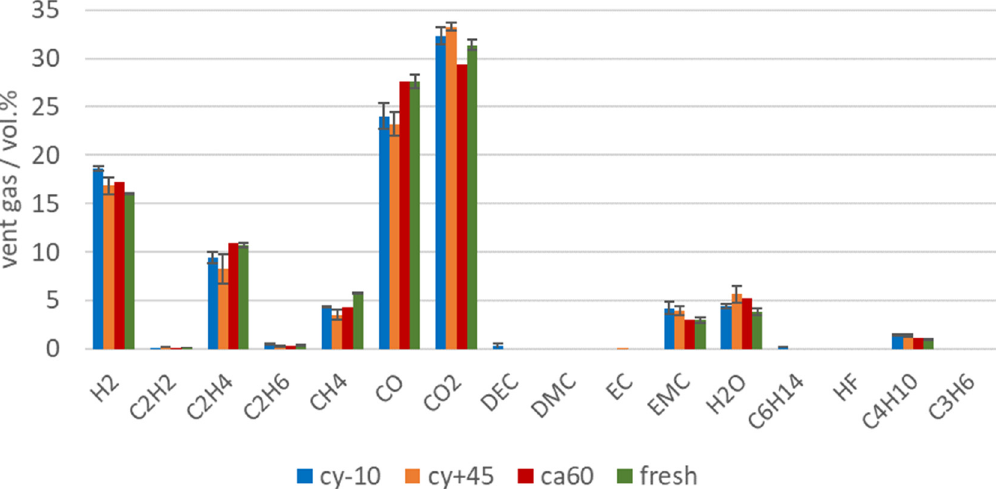
Figure 6. Vent gas composition in vol.% after the TR of aged type #1 cells (cy − 10: blue, cy+45: orange, ca60: red) in overtemperature experiments in comparison to the results of fresh cells (green).